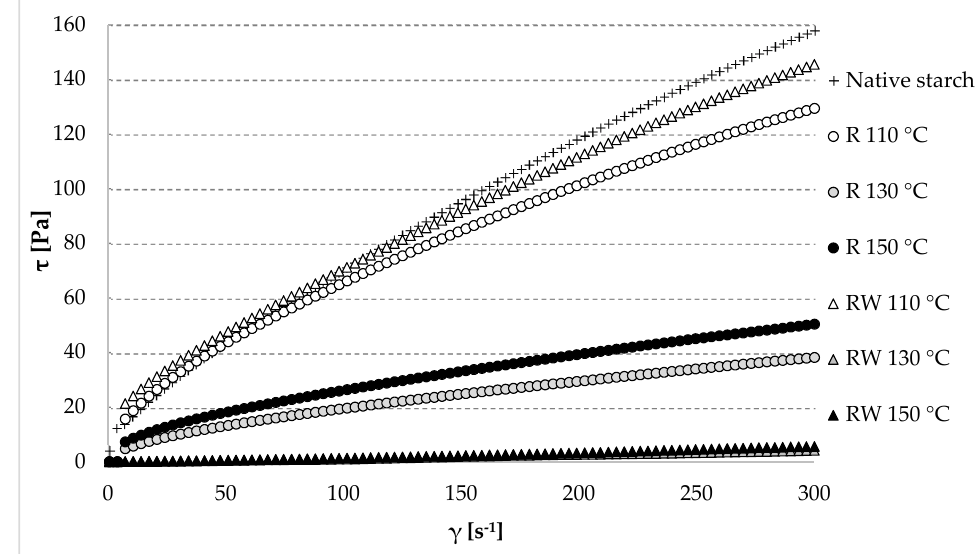
Figure 5. Flow curves of the native and modified starch preparations. The results are expressed as the mean ( n = 3). R—roasted starch without wastewater; RW—roasted starch with wastewater.